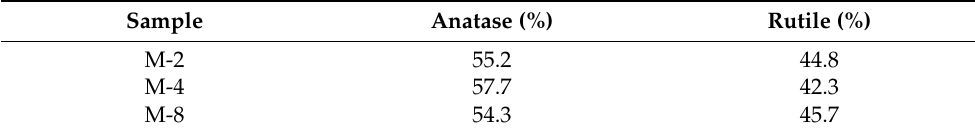
Figure 8. XRD patterns of the TiO 2 feedstock powder, M-2, M-4, and M-8 membranes. Table 6. Phase composition of M-2, M-4, and M-8 membranes.